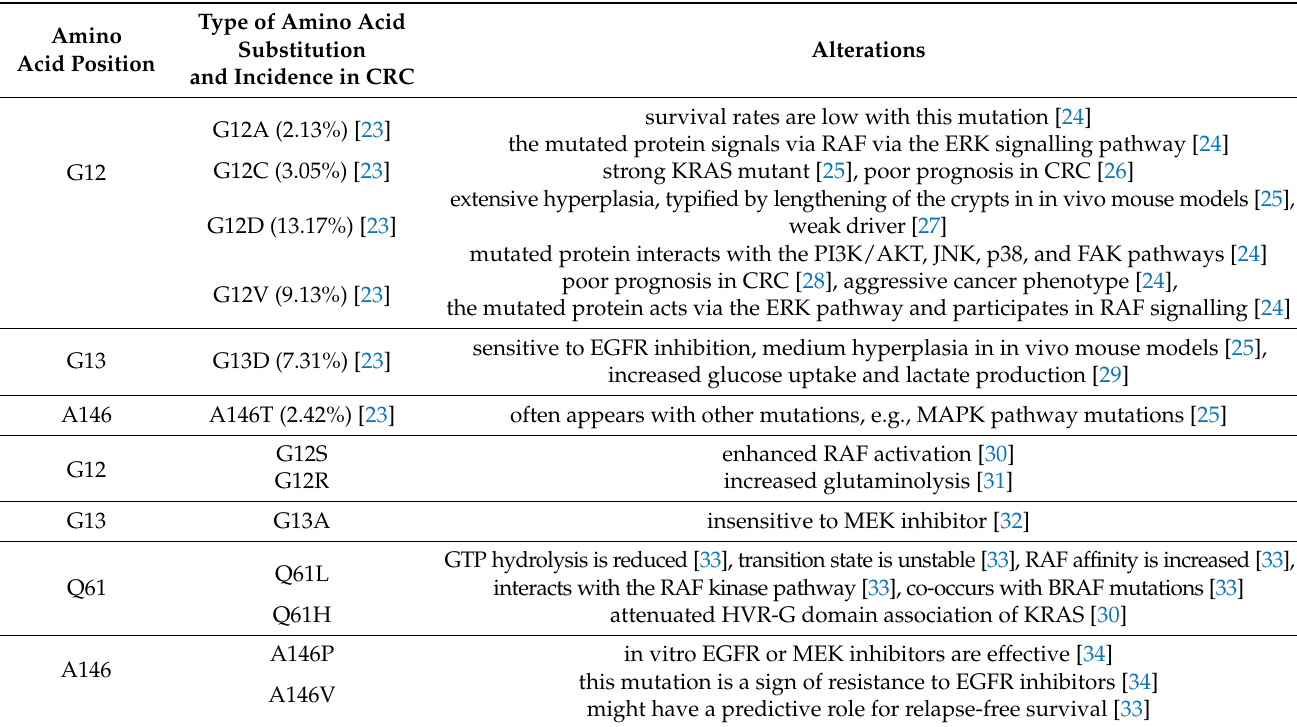
Table 1. An overview of KRAS mutations in CRC. Mutations detected frequently in CRC are in the upper part of the table, and the frequencies of the mutations are indicated based on http://www.cbioportal.org/ (accessed on 3 March